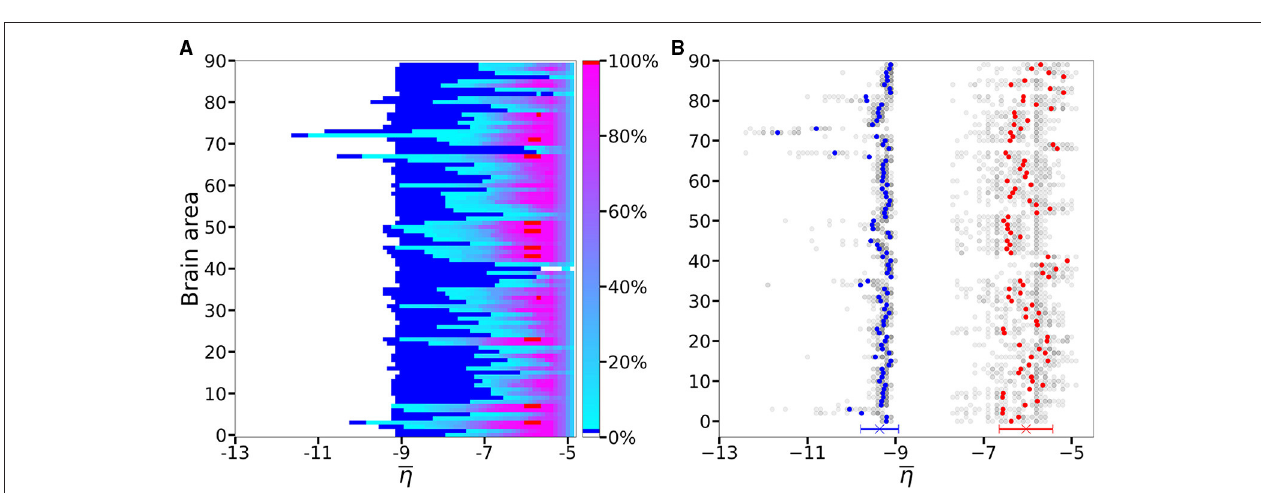
η , as shown in Figures 3A1–E1 , averaged across all subjects. (B) ¯